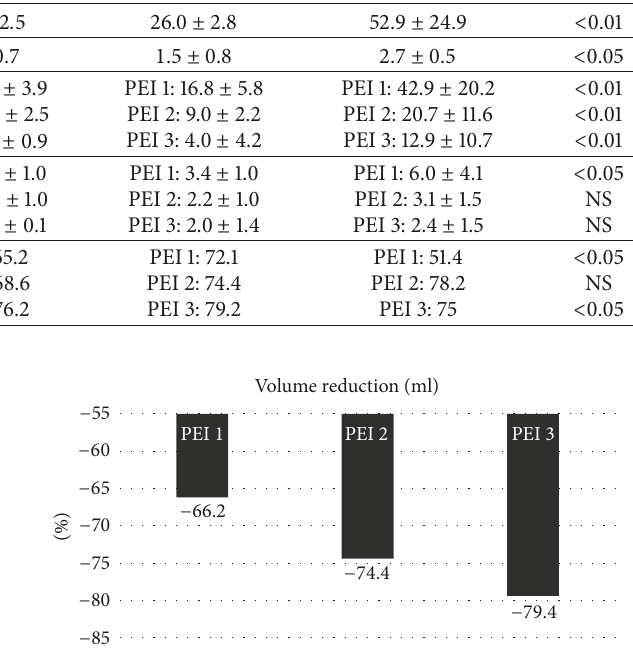
Figure 1: Volume reduction of thyroid cyst.